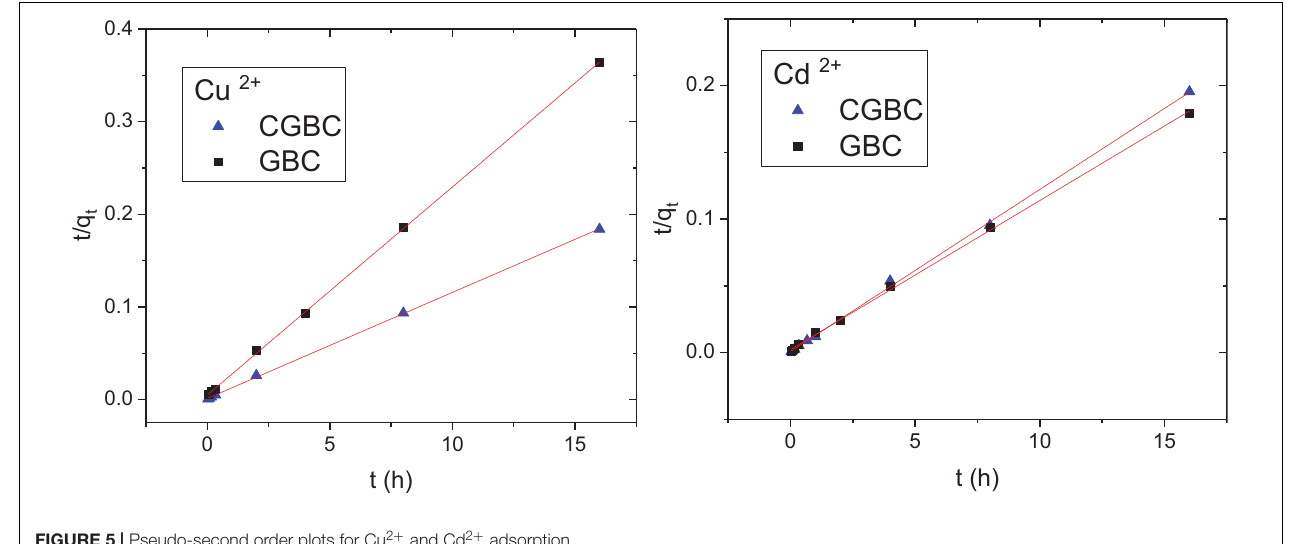
FIGURE 5 | Pseudo-second order plots for Cu 2 + and Cd 2 + adsorption.